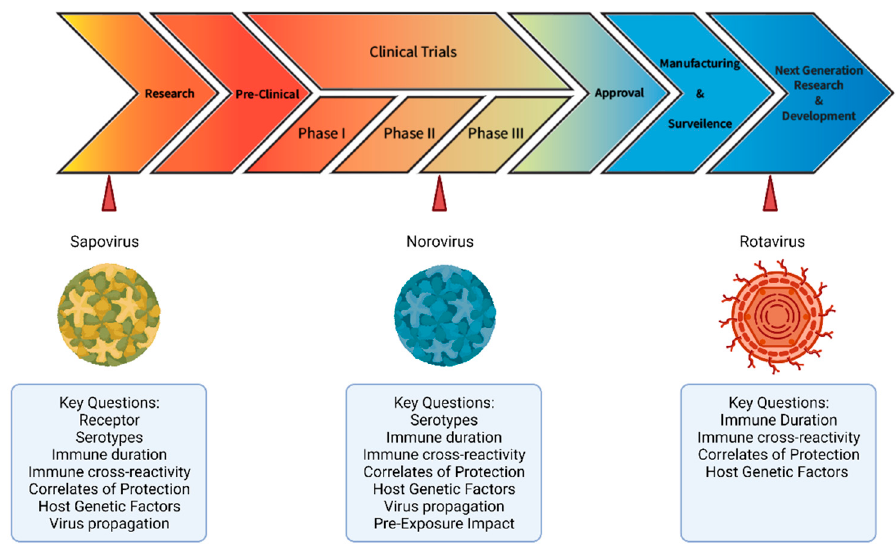
Figure 1. Graphical representation of current stages of research and development for sapovirus, norovirus, and rotavirus vaccines. Created with Adobe Illustrator and BioRender.com (accessed on 05 October 2021).